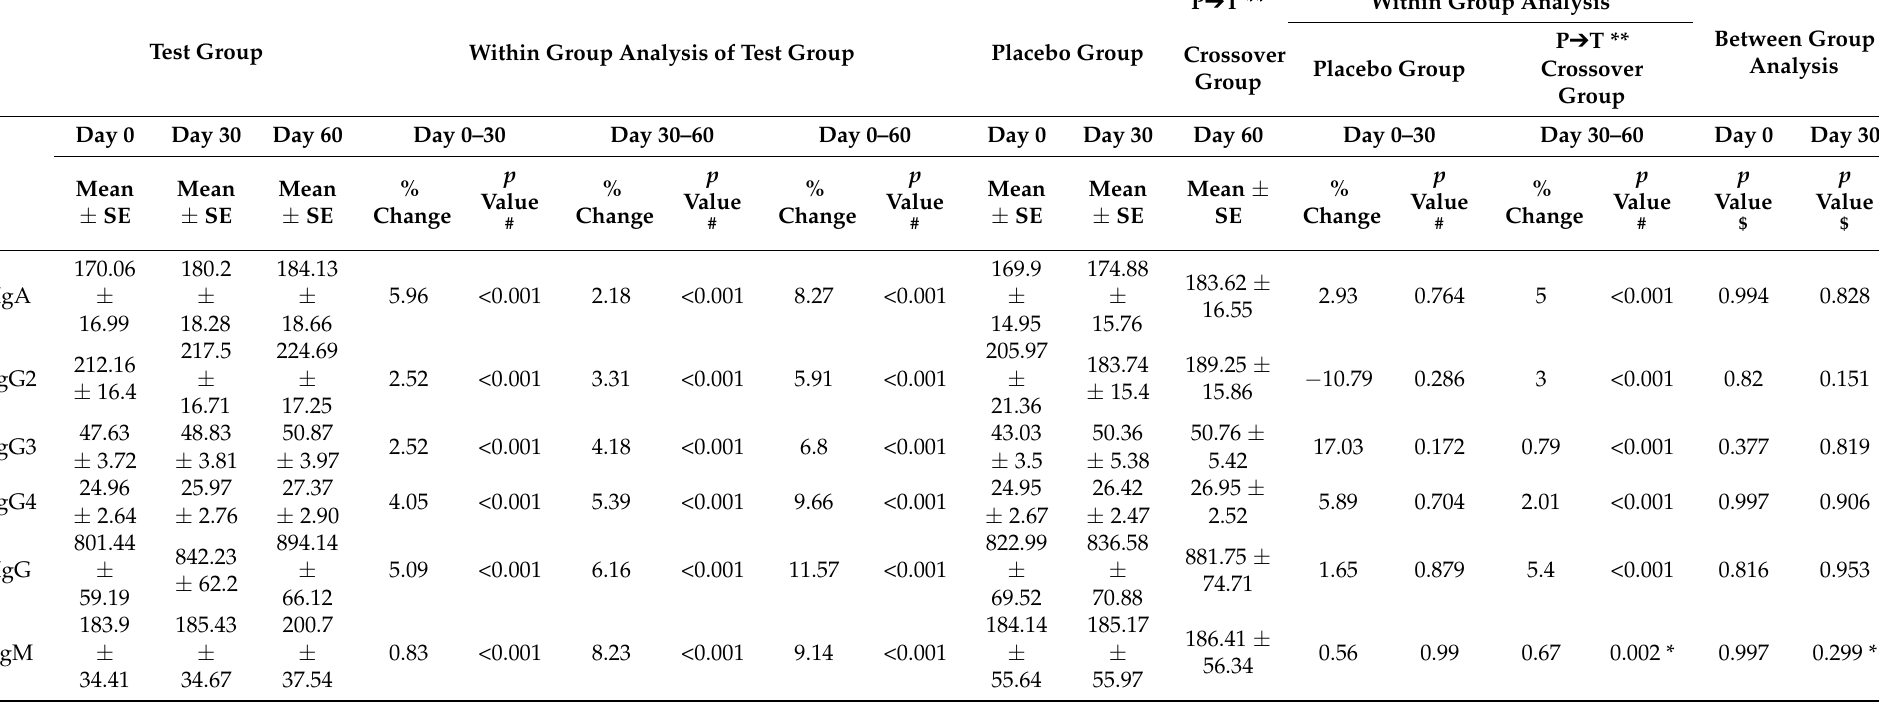
Table 2. Comparison of the level of immunoglobulins (mg/dL) in serum samples of test and placebo group at day 0, 30 and 60 using flow